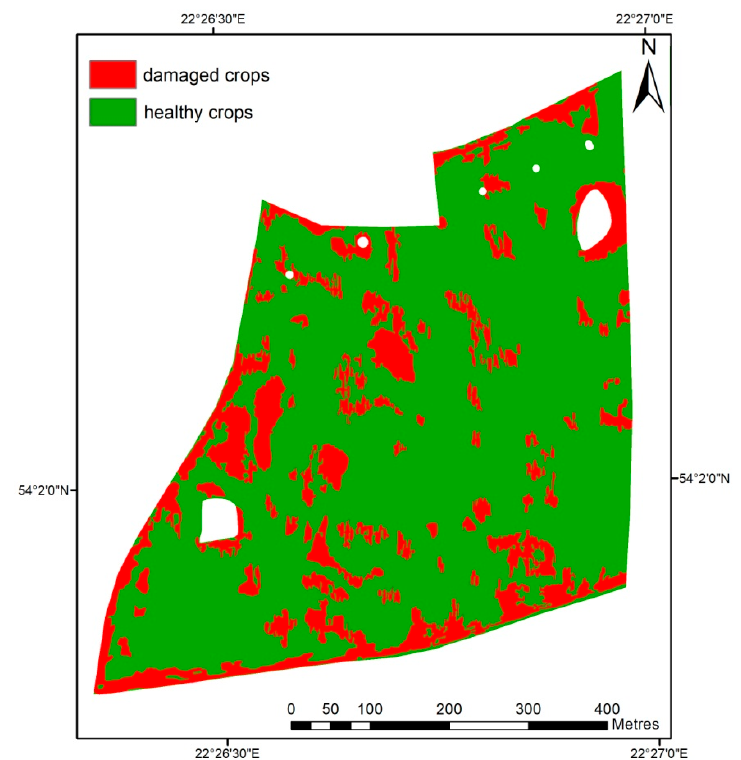
Figure 8. Reference data: crop field map manually vectorized.